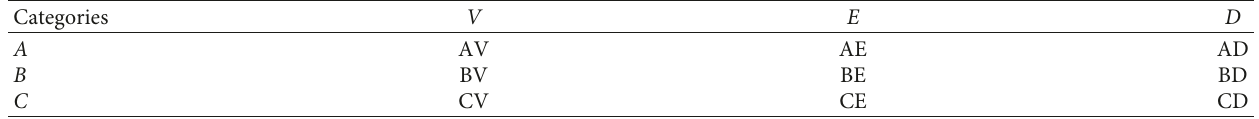
Table 2: Categorization in integrated ABC-VED analysis.